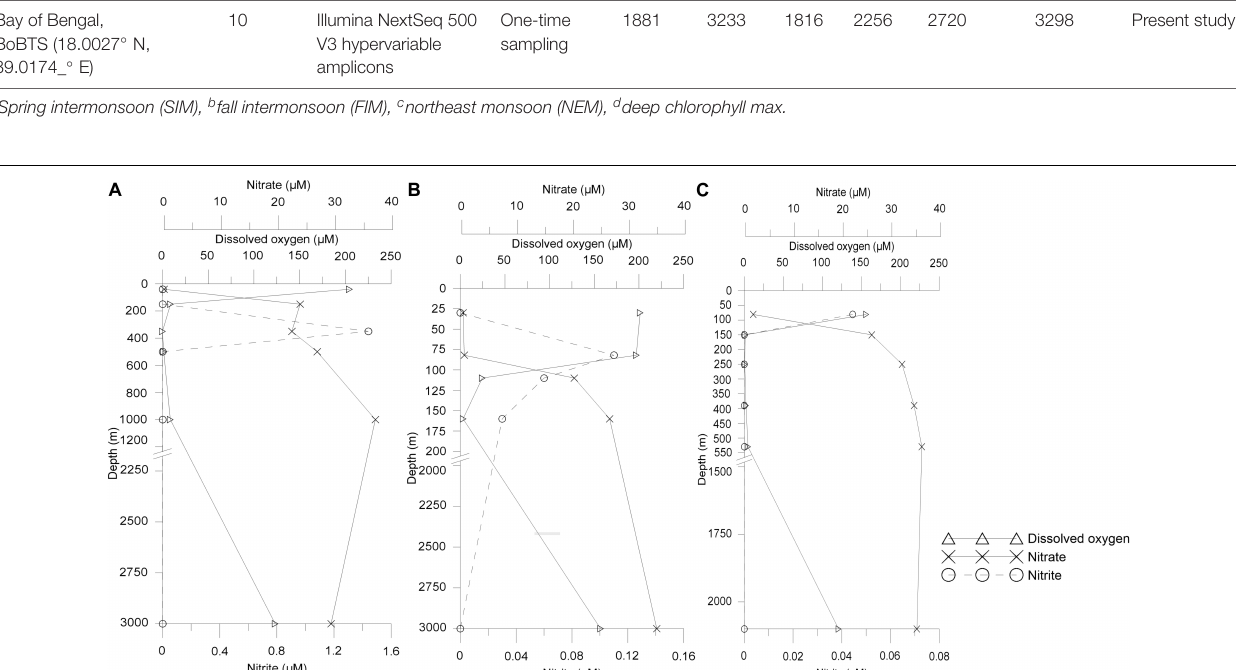
Frontiers in Microbiology |